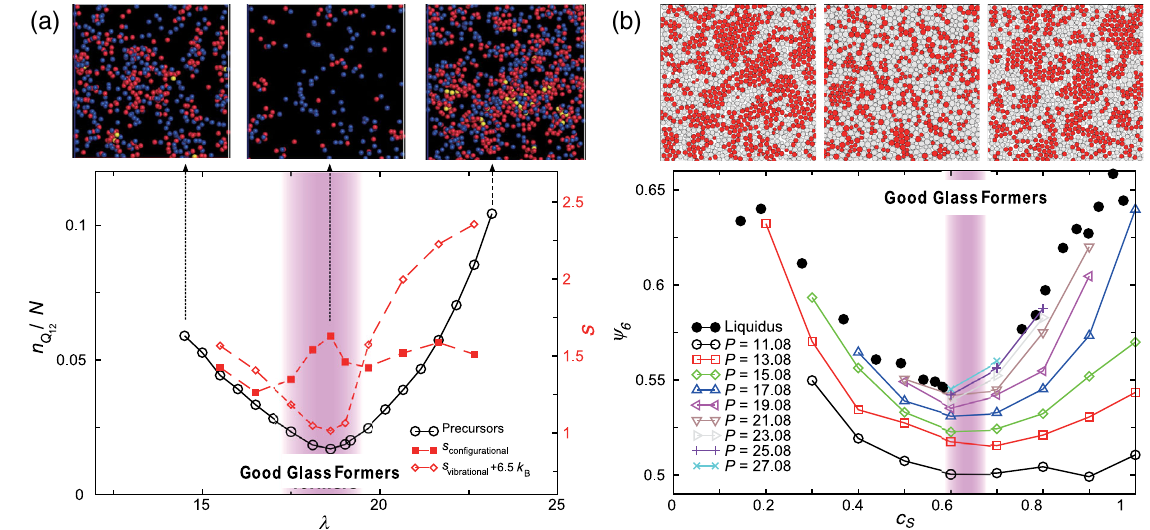
FIG. 4. Fraction of precursors. (a) SW system for β Δ μ ¼ 0 . 6 . Left scale: Open circles (black) represent the average fraction of particles with five or more connected neighbors (precursors). Right scale (in units of k ): Full squares (red) B represent the configurational entropy, and open diamonds (red) the vibrational entropy. The vibrational entropy is shifted by 6 . 5 k for readability. The three top panels are snapshots of configurations at λ ¼ 14 . 5 (left), λ ¼ 18 . 6 (center), and λ ¼ 23 . 15 B (right), where only precursor particles are depicted. The color of the precursor particles depends on the number of connected neighbors: Blue corresponds to five connected neighbors, red to six to nine connected neighbors, and yellow to ten or more connected neighbors. (b) BD system, with average hexatic order ψ 6 at different isobars (open symbols) and along the 1 and β ¼ 1 . The three top panels depict snapshots of liquidus line (full symbols). Pressure is in adimensional units with σ L ¼ 0 . 1456 , 0.6106, and 0.9745, respectively. Disk i is colored red systems along the liquidus line at concentrations c s ¼ if ψ 6 ð i Þ > 0 . 6